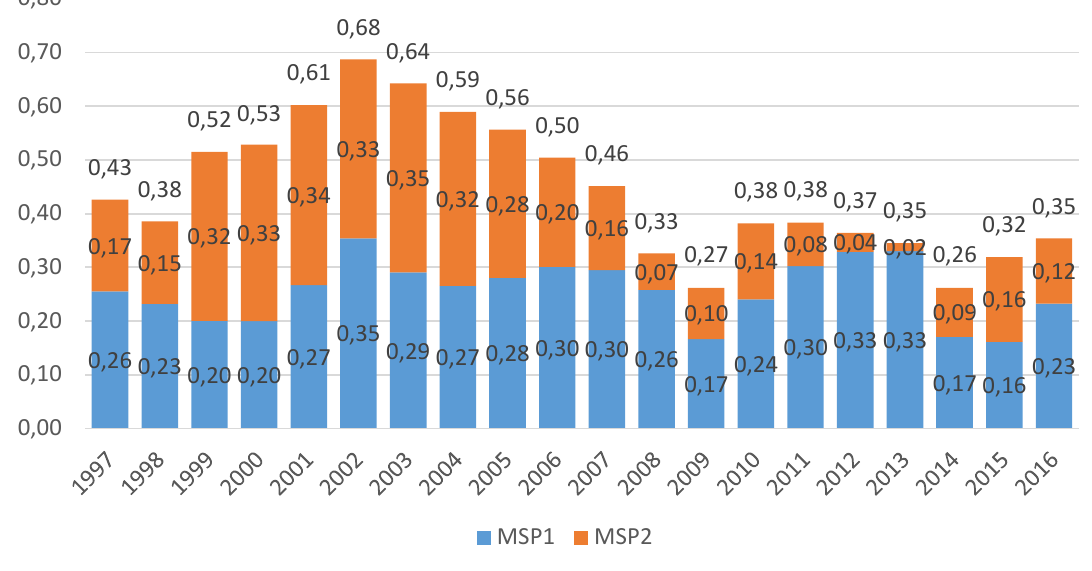
Figure 3. Indicators of internal and external factors